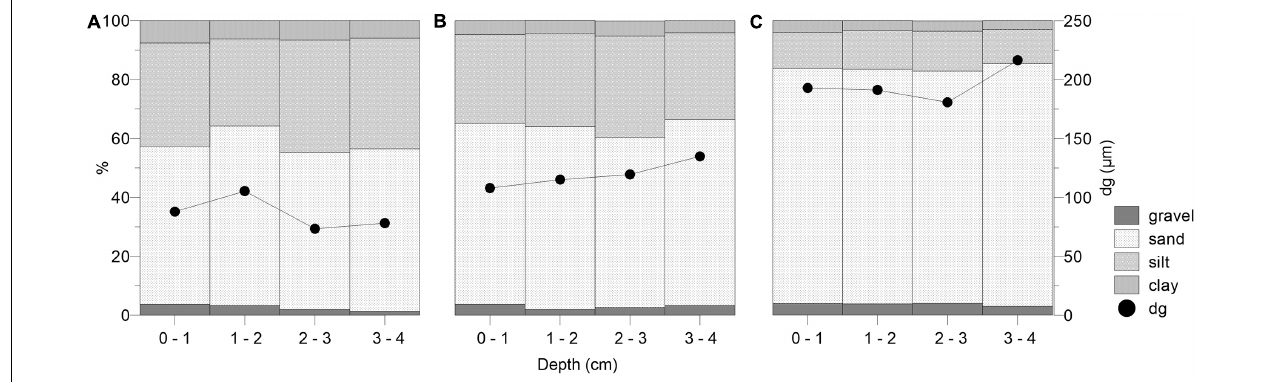
FIGURE 5 | Granulometry composition (%) and median grain size (d g ) of the sediment layers (0–4 cm) underlying mixed settlement (A) , C. cylindracea monospecific settlement (B) , and in non-vegetated sediment (C)